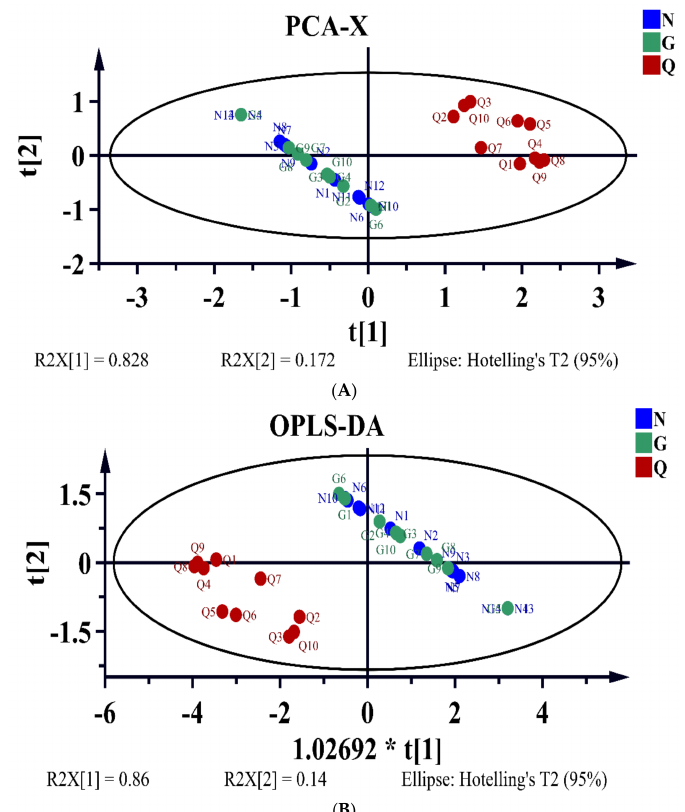
Figure 3. PCA and OPLS-DA plots of 34 batches of LB. ( A ) the PCA-X plot of 34 batches of LB. When zeaxanthin dipalmitate was used as Y variable, β -carotene, and zeaxanthin as X variable, the first two principal components explained 100% of variance (PC1 represented 82.8% and PC2 represented 17.2%) based on the three variables of carotenoids. ( B ) the OPLS-DA plot of 34 batches of LB. R 2 Y and R 2 Q were 76% and 72.8%, respectively, implying a great of reliability and predictability of the